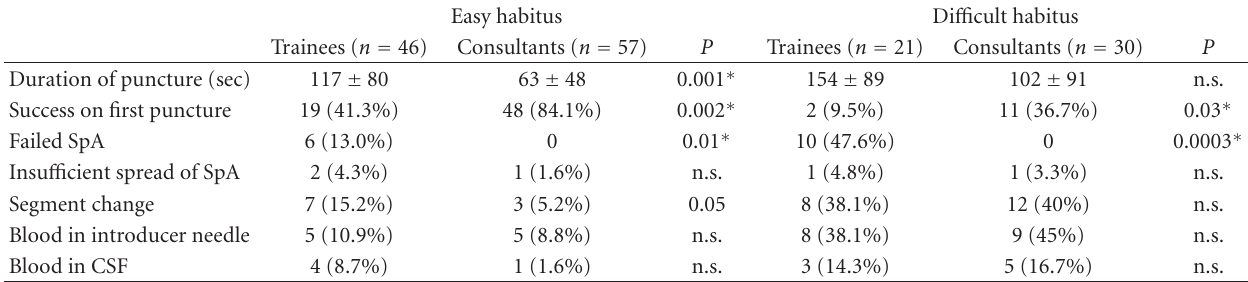
Table 2: Incidences of immediate complications for patients with “easy” and “di ffi cult” habitus and the respective operator experience. Easy habitus